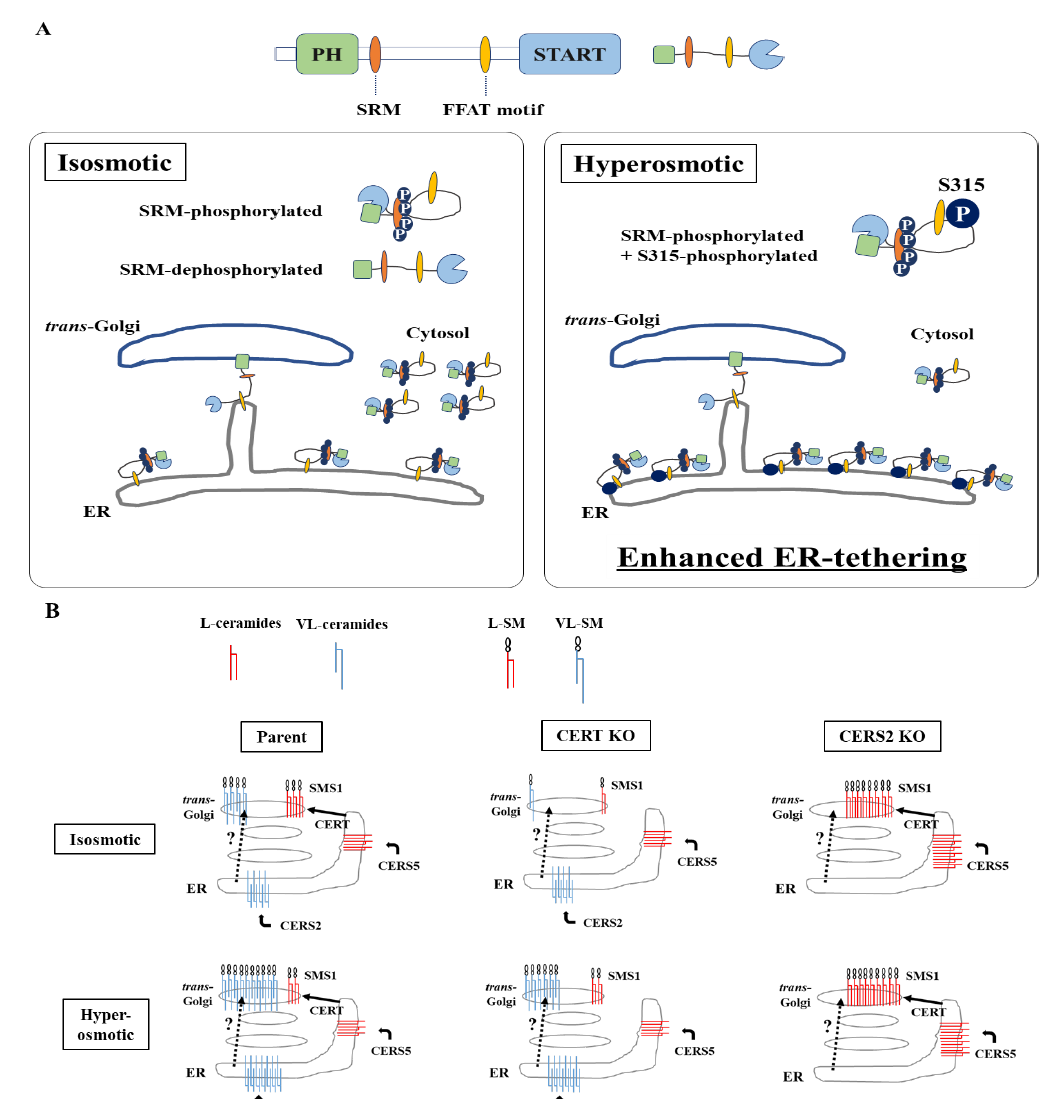
Figure 6. Schematic diagrams of CERT and the ceramide metabolism in response to hyperosmotic stress. ( A ) The enhanced ER-tethering of CERT via the S315-phosphorylation under hyperosmotic conditions. Under isosmotic conditions, a major population of CERT, multiply phosphorylated in the SRM, localizes to the ER or the cytosol, while a minor population of CERT, which is de/hypo- phosphorylated in the SRM, may localize at the ER – Golgi MCSs. Under hyperosmotic conditions, a majority of CERT are phosphorylated at the S315 residue with SRM-hyperphosphorylation resulting in enhancement of tethering to the ER, rather than localization at the ER – Golgi MCSs, via the increased binding of CERT to VAP-A. ( B ) A hypothetical model that may account for the increased VL-SM synthesis under hyperosmotic conditions in a CERT-independent manner. Ceramide synthesized in the ER is transported to the trans -Golgi, where SM synthase 1 (SMS1) locates, via a CERT-dependent (solid line) or -independent (dotted line) pathway. In wild-type HeLa cells under isosmotic conditions, long-chain ceramides (L-ceramides), which are mainly catalyzed by CERS5, are delivered from the ER to the distal Golgi regions preferentially via the CERT-dependent pathway, whereas very-long-chain ceramides (VL-ceramides), which are mainly catalyzed by CERS2, are presumably transported to the proximal or more broad Golgi regions via a CERT-independent pathway(s), of which the entity remains elusive. Under hyperosmotic conditions, the synthesis of VL-ceramides is enhanced, and therefore, a greater amount of VL-ceramides is delivered to the Golgi via the CERT-independent pathway, thereby enhancing the synthesis of VL-SM.